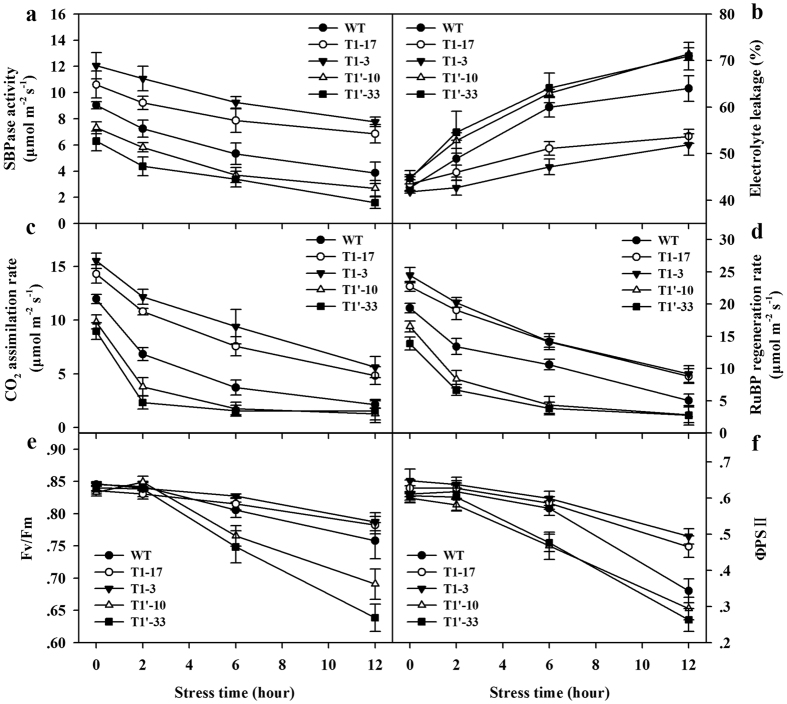
Effects of changes in SBPase activity on chilling tolerance in transgenic tomato plants.All measurements were done on 12-leaf wild-type and T1 progeny of transgenic tomato plants subjected to chilling stress at 5 °C for 12 h. (a) Changes in SBPase activity in response to chilling stress in transgenic plants. (b) Changes in electrolyte leakage in response to chilling stress in transgenic plants. (c) Changes in CO2 assimilation rates in response to chilling stress in transgenic plants. (d) Changes in RuBP regeneration rate in response to chilling stress in transgenic plants. (e,f) Changes in the maximum potential quantum efficiency (Fv/Fm) and the actual quantum efficiency (ΦPSII) of photosystem II in response to chilling stress in transgenic plants. The results are the means ± SDs (n > 4).